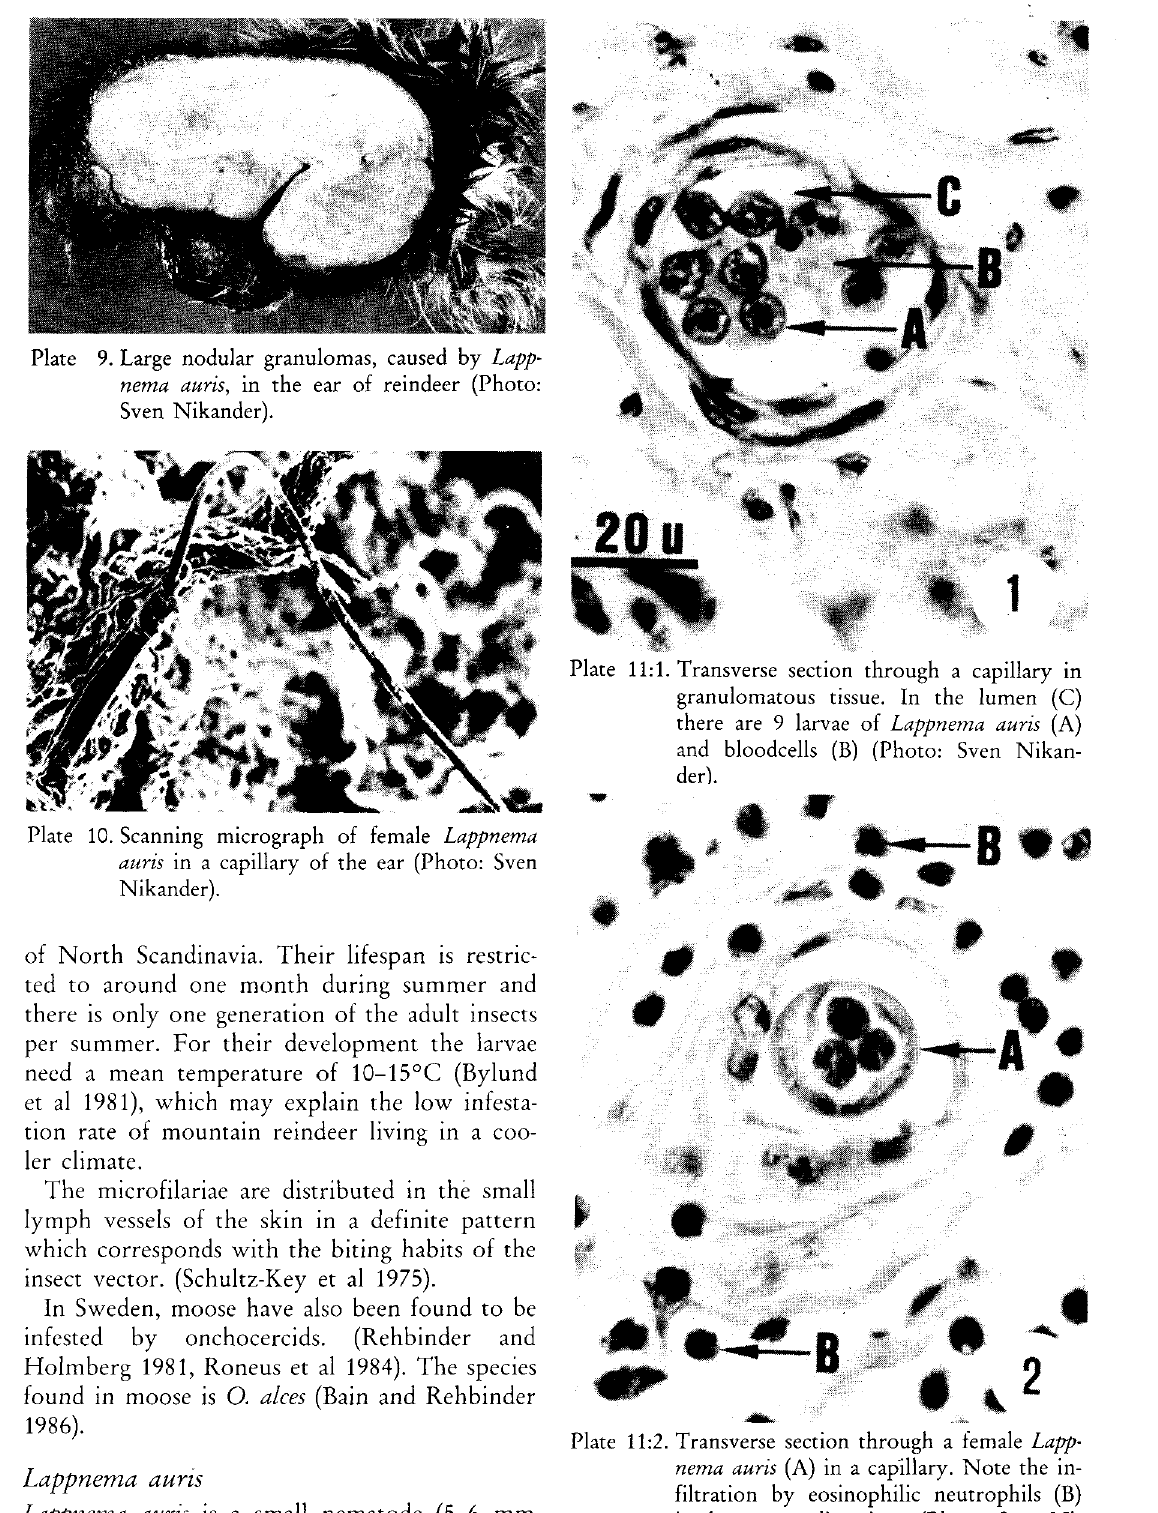
Plate 11:2. Transverse section through a female Lapp nema auris (A) in a capillary. Note the in filtration by eosinophilic neutrophils (B) in the surrounding tissue (Photo: Sven N i